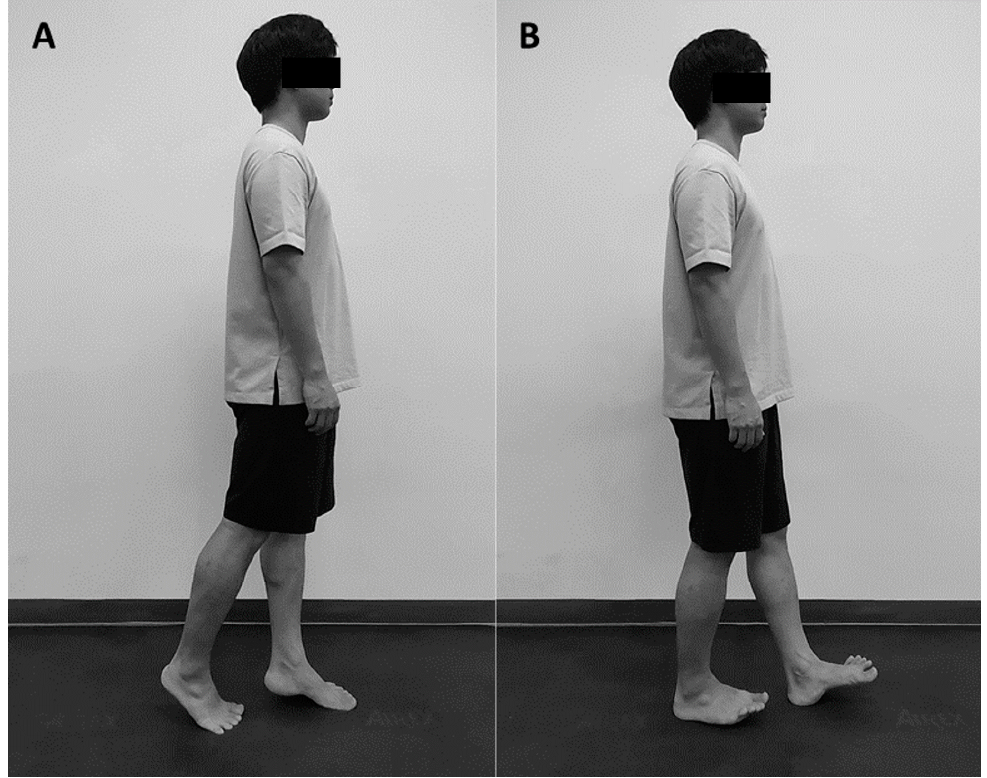
Figure 2. Tandem exercise. ( A ) Forward movement; ( B ) Backward movement.